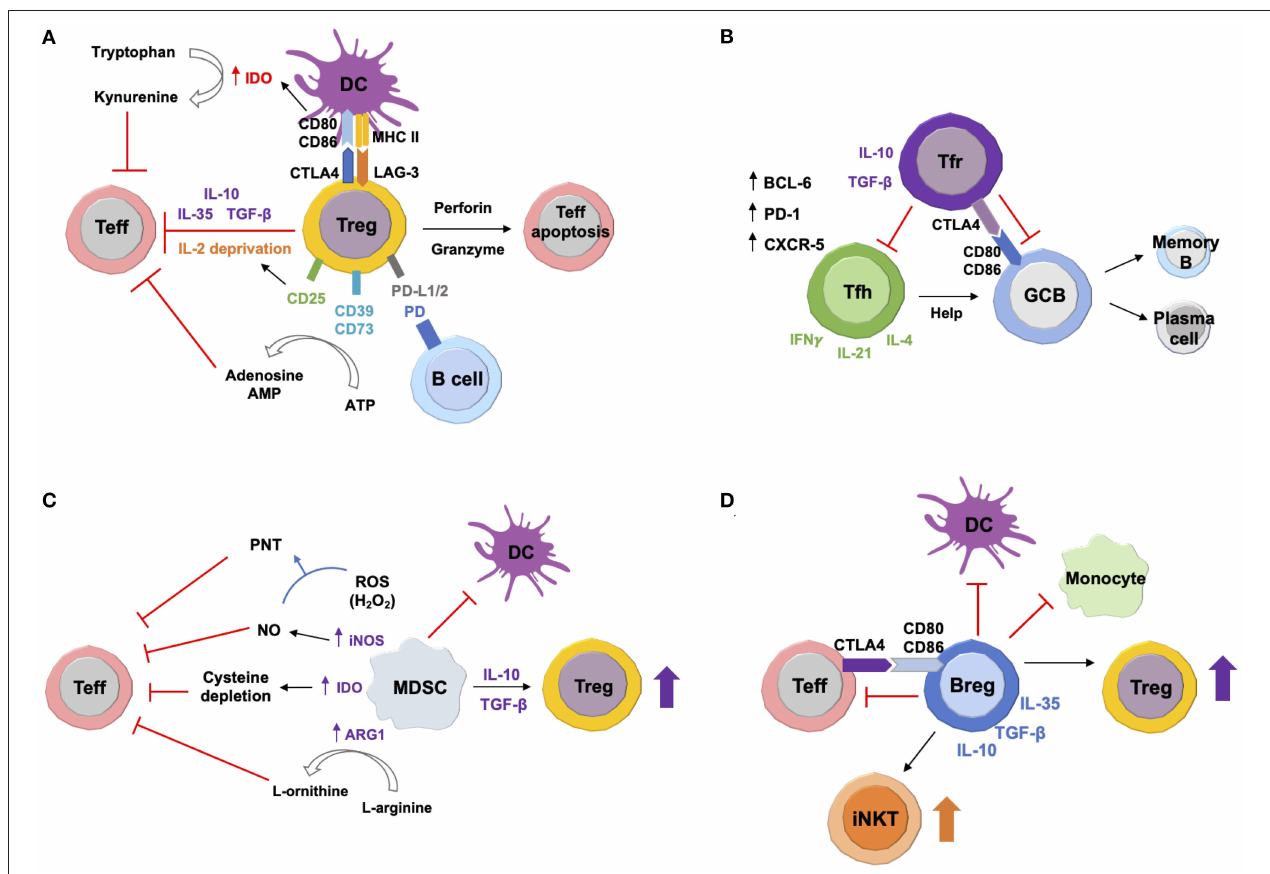
FIGURE 1 | Suppressive Mechanisms of Immunoregulatory Cells. (A) Tregs secrete anti-inflammatory cytokines IL-10, transforming growth factor beta (TGF- β ), and IL-35, thus inhibiting target effector T (Teff) cells. Production of perforin and granzyme causes Teff cell apoptosis. Constitutively high expression of CD25 depletes IL-2, which attenuates Teff cell proliferation. Interaction with dendritic cells (DCs) via cytotoxic T-lymphocyte-associated protein 4 (CTLA-4) and lymphocyte-activation gene 3 (LAG-3) downregulates CD80/CD86 expression, which induces upregulation of indoleamine 2,3-dioxygenase (IDO). This enzyme expressed by DCs converts tryptophan to kynurenine, leading to Teff cell exhaustion. Surface expression of CD39 and CD73 converts extracellular adenosine triphosphate (ATP) to immunosuppressive adenosine and adenosine monophosphate (AMP). Tregs can also suppress autoreactive B cells via programmed death (PD) ligands 1 and 2 (PD-L1/2). (B) In germinal centers (GCs), both follicular helper T (Tfh) and follicular regulatory T (Treg) cells express transcription factor B cell lymphoma 6 (BCL6), surface marker PD-1, and C-X-C motif chemokine receptor 5 (CXCR5). Tfh cells produce IL-4, IL-21, and interferon gamma (IFN γ ). They provide help signals to GC B cells and promote their differentiation into antibody-secreting plasma cells and memory B cells. Tfr cells regulate GC responses by inhibiting both Tfh and B cells via anti-inflammatory IL-10 and TGF- β . Tfr cells can also directly suppress GC B cells via CTLA-4. (C) Myeloid-derived suppressor cells (MDSCs) produce high levels